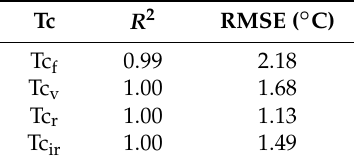
Figure 2. Daily Crop Water Stress Index (CWSI) for tall fescue ( A ), grapevines ( B ), above the vine row ( C ) and interrow ( D ) in 6.1 m during the months of May to October, from 2010–2013. Vineyard median EVI ranged from 0.22–0.72 (Figure 3), with a mean within-vineyard range (calculated as the difference of maximum and minimum EVI) of 0.18. Median vineyard LST ranged from 16.0–40.1 ◦ C from 2010 to 2013, with a mean range within the vineyard of 4.44 ◦ C (Figure 4). Median EVI within the EC footprint followed a seasonal pattern and ranged from 0.28–0.65 (Figure 5A). Median LST within the EC footprint also followed a seasonal pattern and ranged from 0.8 to 42.6 ◦ C (Figure 5B). The LST was significantly related to Tc at overpass time and lowest RMSE of 1.13 ◦ C was measured with an IRT sensor at 6.1 m above the grapevine row (Table 2). Table 2. The RMSE ( ◦ C), and R 2 of linear regression models with Tc ( ◦ C) measured with IRT sensors at time of satellite overpass as independent variable, and LST ( ◦ C) as dependent